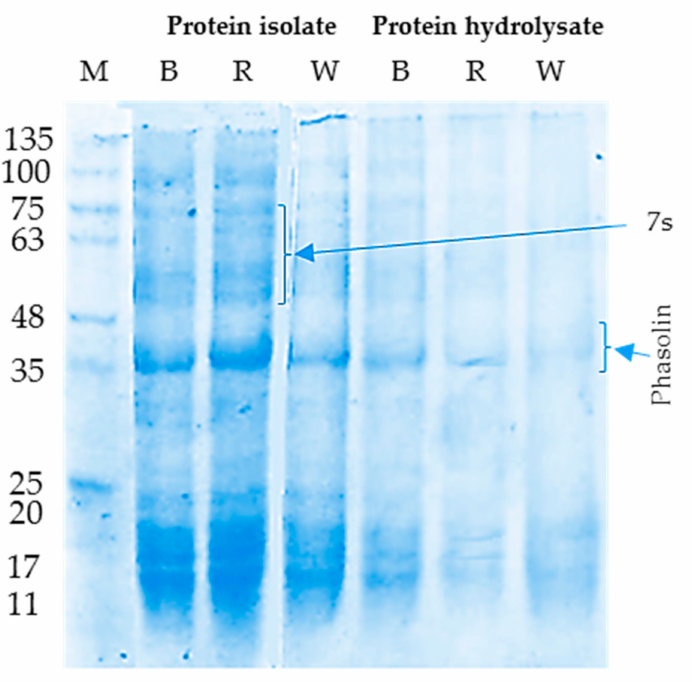
Figure 1. SDS-PAGE profile: (Lanes, 1–3) are for protein isolates and lanes 4–6 for protein hydrolysates (30 min Alcalase hydrolysis at 37 ◦ C), isolated from black (B), red (R), and white (W) kidney bean seeds.M, molecular